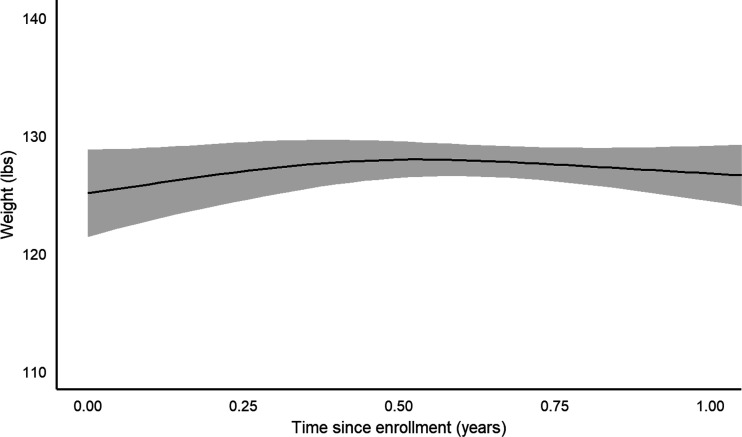
Estimated Change in Weight Over Time After Enrollment in Rural Diabetes Care Program, Guatemala